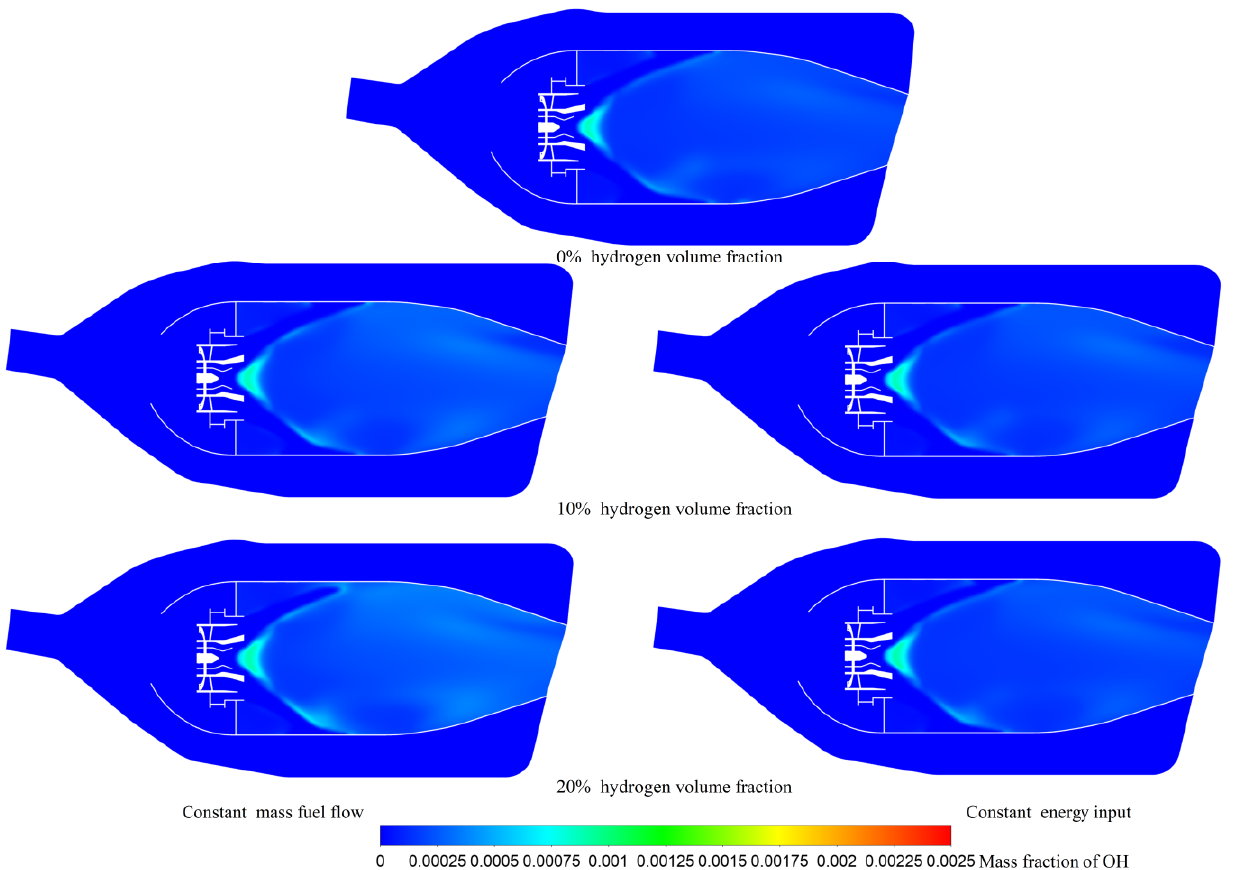
Figure 10. Contours for the mass fraction of OH on the central plane of the combustor under different fuel conditions.